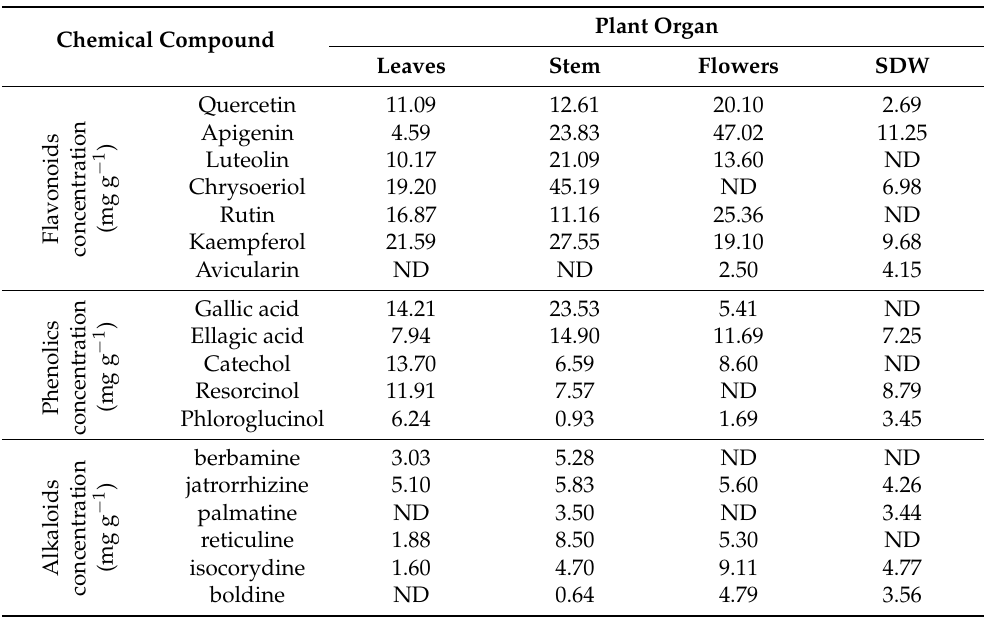
Table A1. HPLC analysis of the phenolic, flavonoid, and alkaloid contents of the different organs